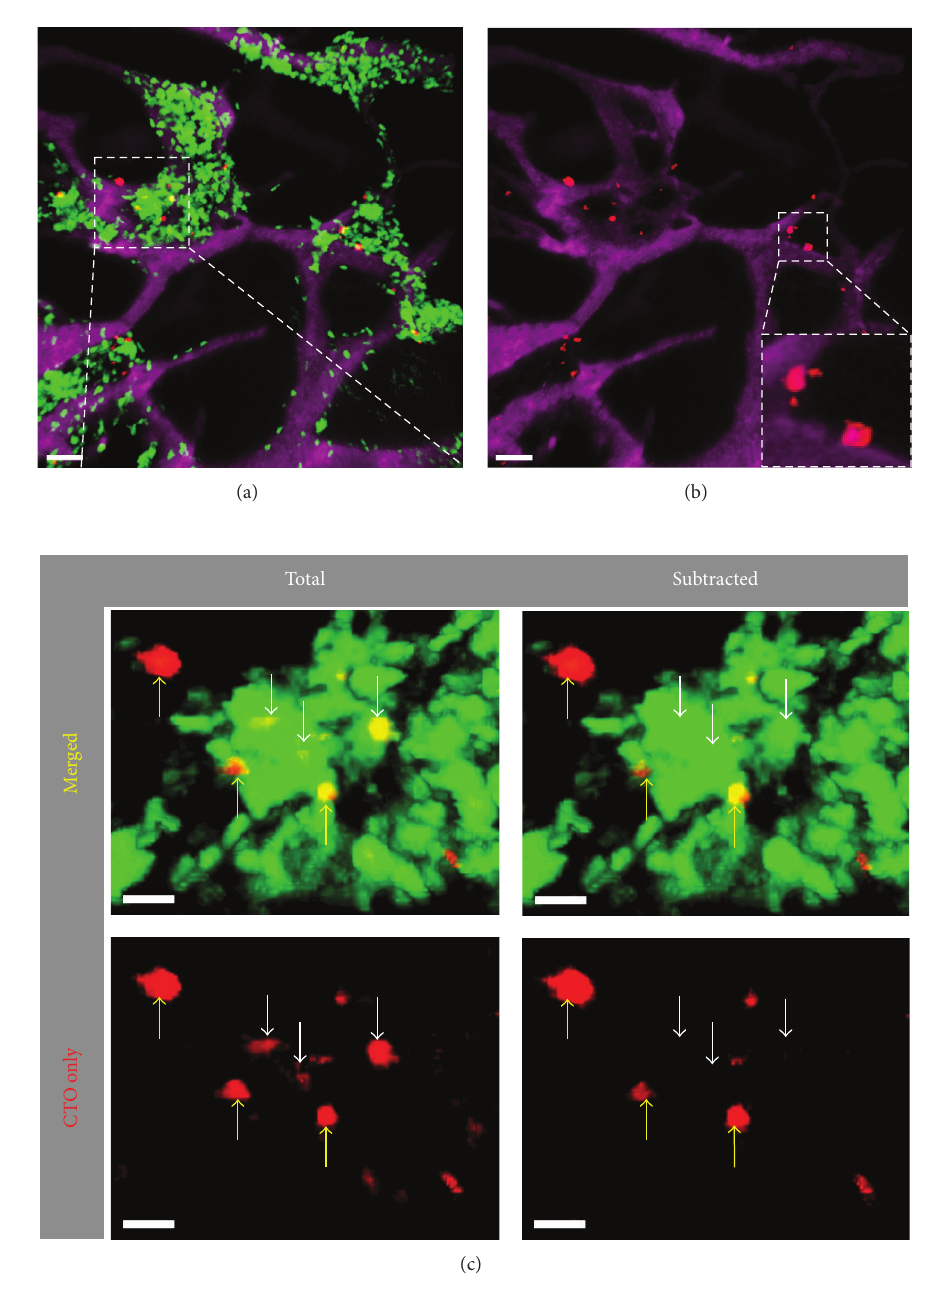
Figure 2: Distribution of CTO-labeled hMSCs in the calvarium of a 𝐿𝑦𝑠𝑀 +/𝐺𝐹𝑃 mouse. A total of 8 × 10 6 CTO-labeled hMSCs (red) were injected i.v. into a 𝐿𝑦𝑠𝑀 +/𝐺𝐹𝑃 recipient mouse containing LysM + (green) neutrophils and monocytes. Intravital TPM was performed through intact calvarium of live recipient mice 20 hours after i.v. injection of hMSCs. (a) Distribution of labeled hMSCs in the calvarium bone marrow withinthegeneralvicinityofbonemarrow-residentLysM + myeloid-lineagecells.VesselswerehighlightedwithQtracker-655(magenta).Scale bar = 50 𝜇 m. (b) Same image as in (a) after channel subtraction to remove CTO signal inclusions inside of the LysM + GFP signals, showing close association of the hMSCs with the vessels (inset). (c) Zoomed-in view of the inset in (a), showing that many hMSCs (red) remain intact in the bone marrow and do not colocalize with the GFP signal (yellow arrows). However, a small number of LysM + granulocytes can be seen to harbor CTO + inclusions inside the cell body (white arrows). Channel subtraction of the micrograph in the left column removed CTO signal that resided within LysM + cell body, further supporting the presence of CTO signal inside a few LysM + cells (right column; white arrows). Scale bars = 20 𝜇